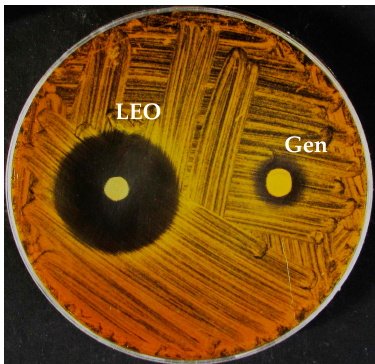
Figure 1. Representative image showing antibacterial activity against a bacterial strain.